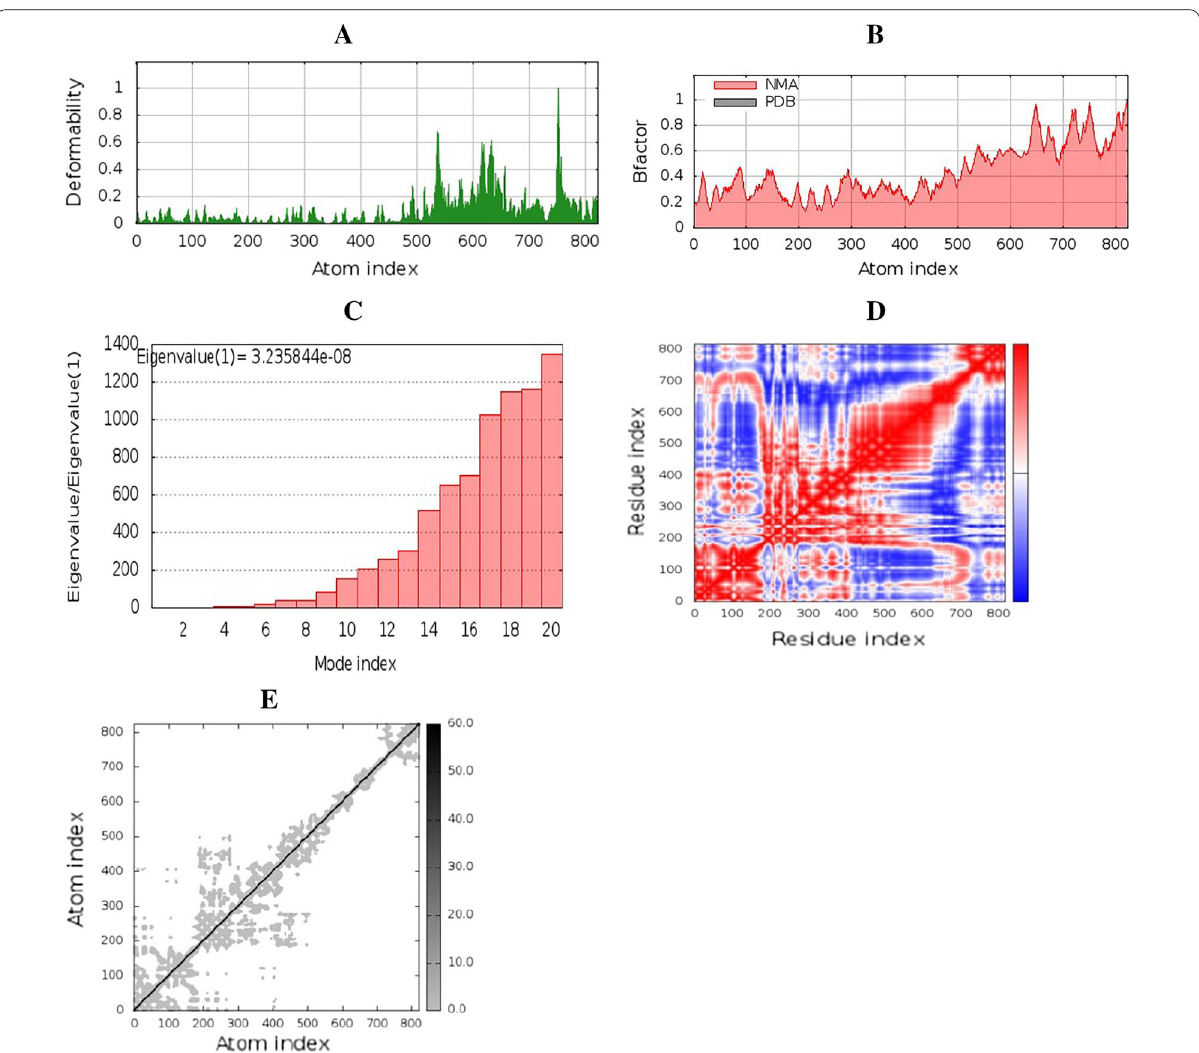
Fig. 8 Molecular dynamics simulation of multi-epitope vaccine—HLA-A02:01 complex; stability of the protein–protein complex was investigated through deformability ( A ), B-factor values ( B ), eigenvalue ( C ), covariance of residue index ( D ) and elastic network ( E )